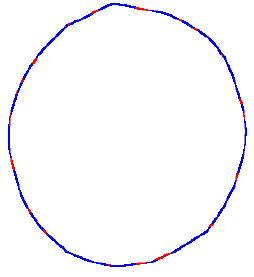
Figure 10. Nonconvex sections of the simulated path of the diameter tape constructed by a cubic B-spline. The red sections are nonconvex sections.